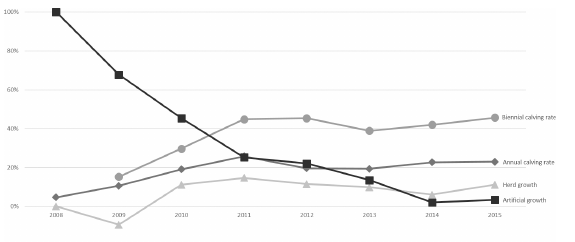
Fig 1. Comparison between the total herd growth, annual and biennial calving rate and the artificial growth. The y-axis shows the total percentage and the x-axis shows the time in years. In 2008 the breeding operationstarted with new arrivalswhich explainsthe 100%of artificial growth.